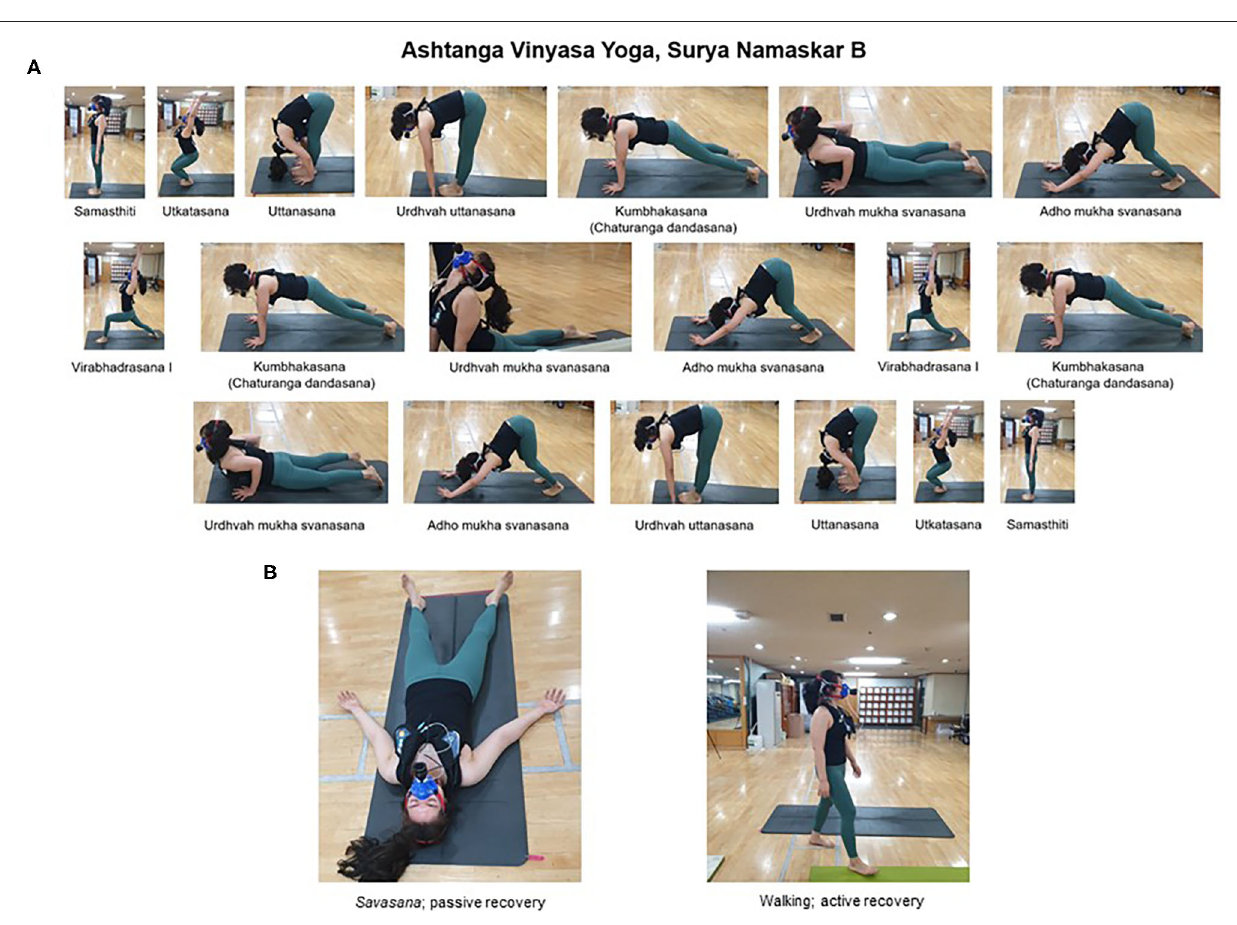
FIGURE 2 | (A) Sequence of high-intensity hatha yoga: Ashtanga Vinyasa Yoga, Surya Namaskar B (10-min duration). (B) Savasana ; passive recovery, Walking; active recovery (40–45% of estimated maximal heart rate, 10-min duration).